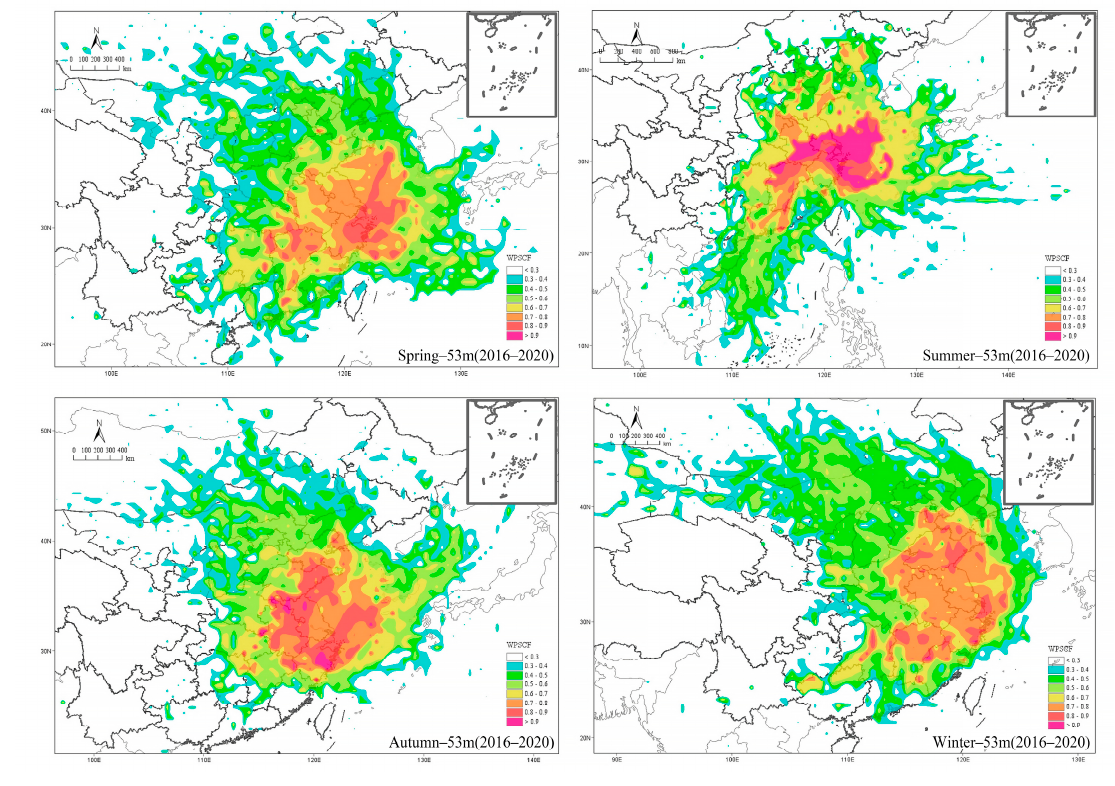
Figure 6. Potential CH 4 emission areas.